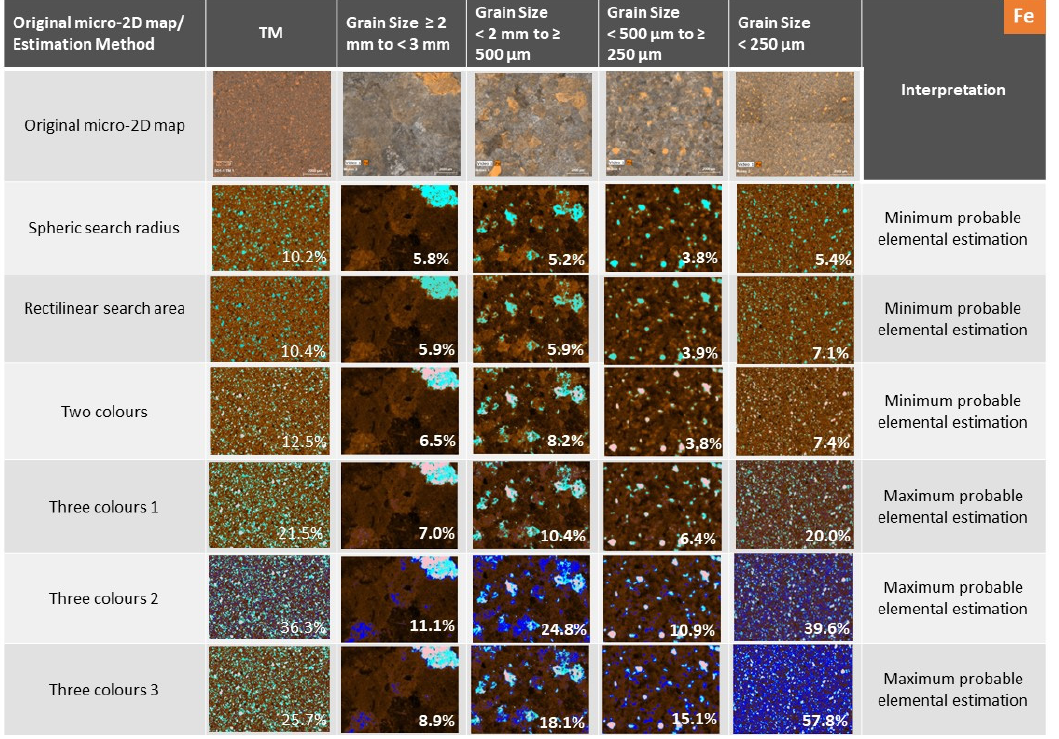
Figure 6. Minimum and maximum probable elemental occurrence in µ-XRF 2D map (percentage of area %) for Fe.